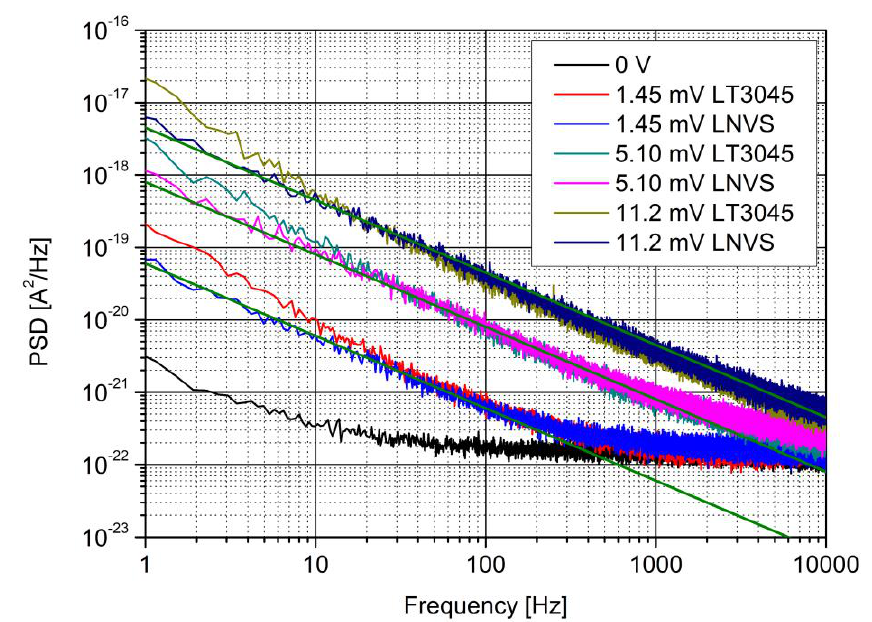
Figure 10. Current noise measurement results of the photodetector with a bias network using different voltage sources.